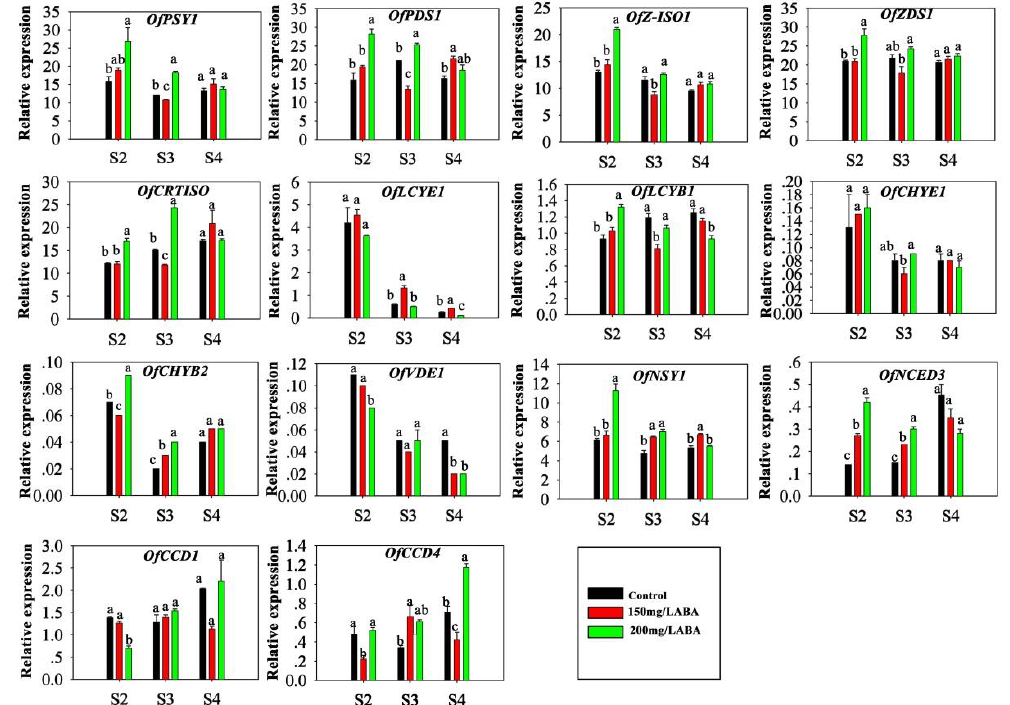
Figure 2. Expression levels of genes involved in carotenoid metabolism in ‘Yanhonggui’ petals receiving ABA treatments. Tukey’s multiple-range test was used, and least significant range analysis at 5% significance is shown by lowercase letters for the same stage for the control and treatments. All experiments were performed in triplicate. Data are shown as means ± SEM. Means followed by the same letter do not differ significantly.